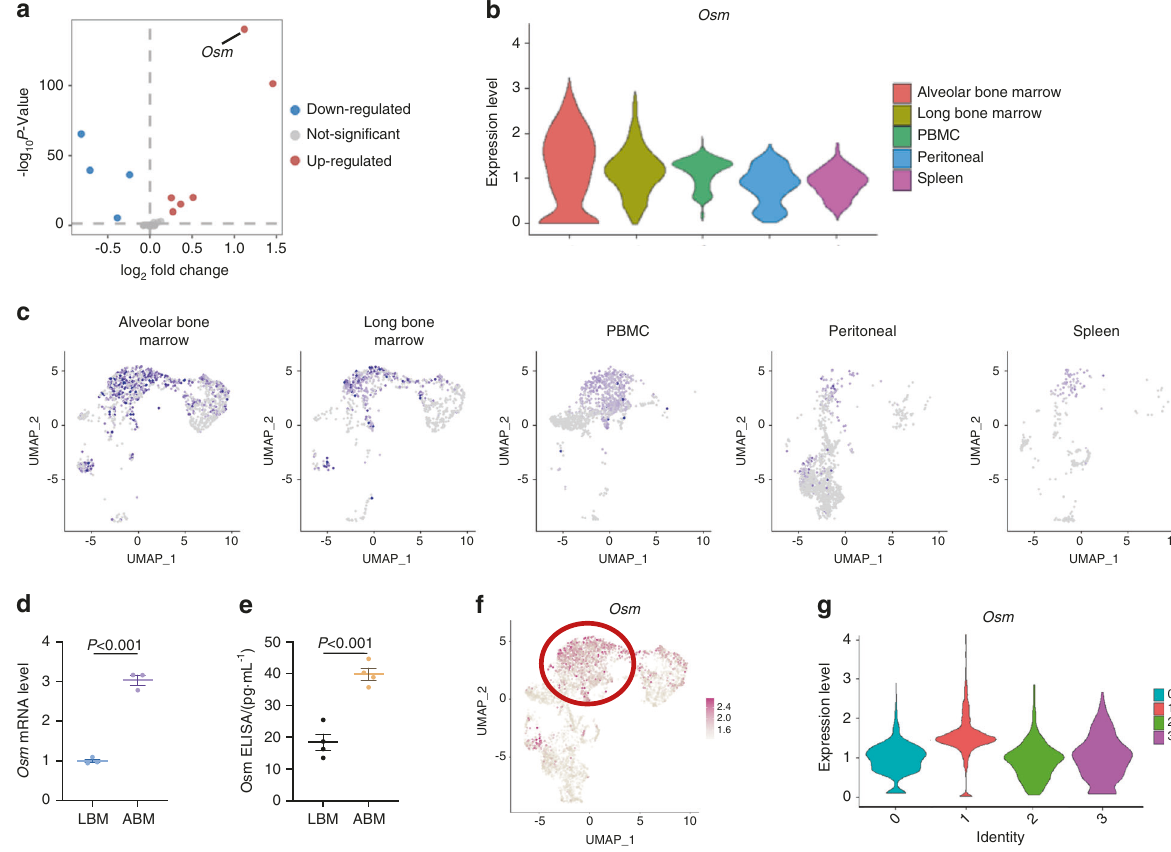
Fig. 6 Osm is highly expressed in ABM. a The volcano plot shows 59 cytokines between ABM and LBM-derived monocyte/macrophage populations. Red symbol, signi fi cantly upregulated cytokines. Blue symbol, signi fi cantly downregulated cytokines. b Violin plot for the expression levels of Osm in monocytes/macrophages from different tissues. c Osm expression in monocytes/macrophages split by tissue origin. d RT-qPCR results of Osm levels in monocytes/macrophages derived from ABM and LBM. e ELISA for Osm in ABM and LBM homogenates. f Osm expression levels in different cells projected on UMAP plot. g Violin plot for the expression levels of Osm in different monocyte/macrophage